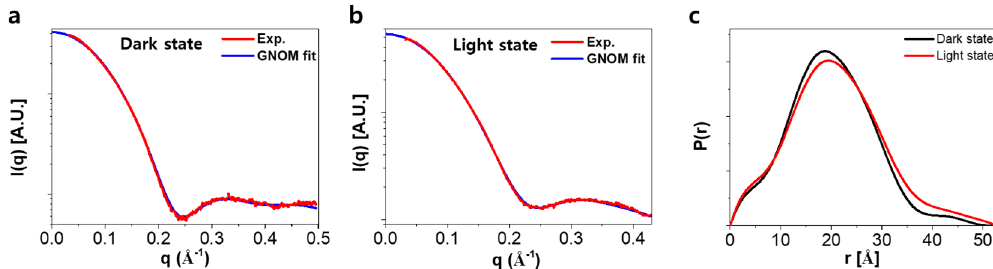
Figure 3. SAXS (red) and GNOM fit results (blue) for BM(PEG) 2 -incorporated PYP (SML-PYP) in the dark ( a ) and the light ( b ) states. ( c ) Pair distribution, P(r) , of SML-PYP with (red) and without (black) exposure to light. P(r) functions show that the light state of SML-PYP has a larger R max value. A. U. stands for arbitrary unit.